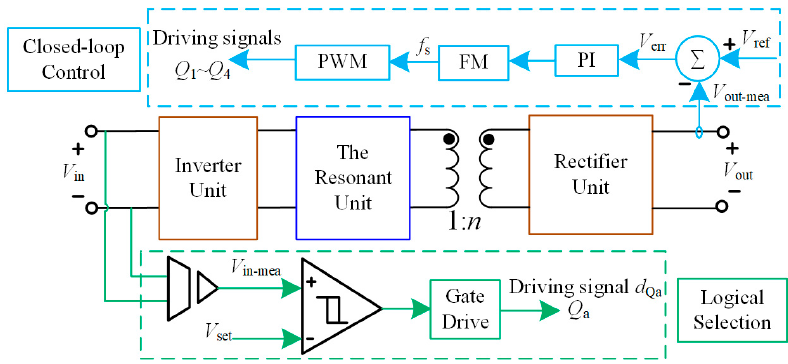
Figure 19. Control strategy scheme of the proposed converter.